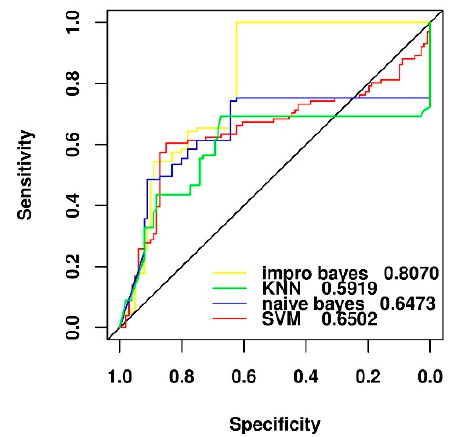
Figure 3. Performance comparison of different machine learning algorithms for the N2 negative data set by using our feature selection method of leave-one-out cross validation test.